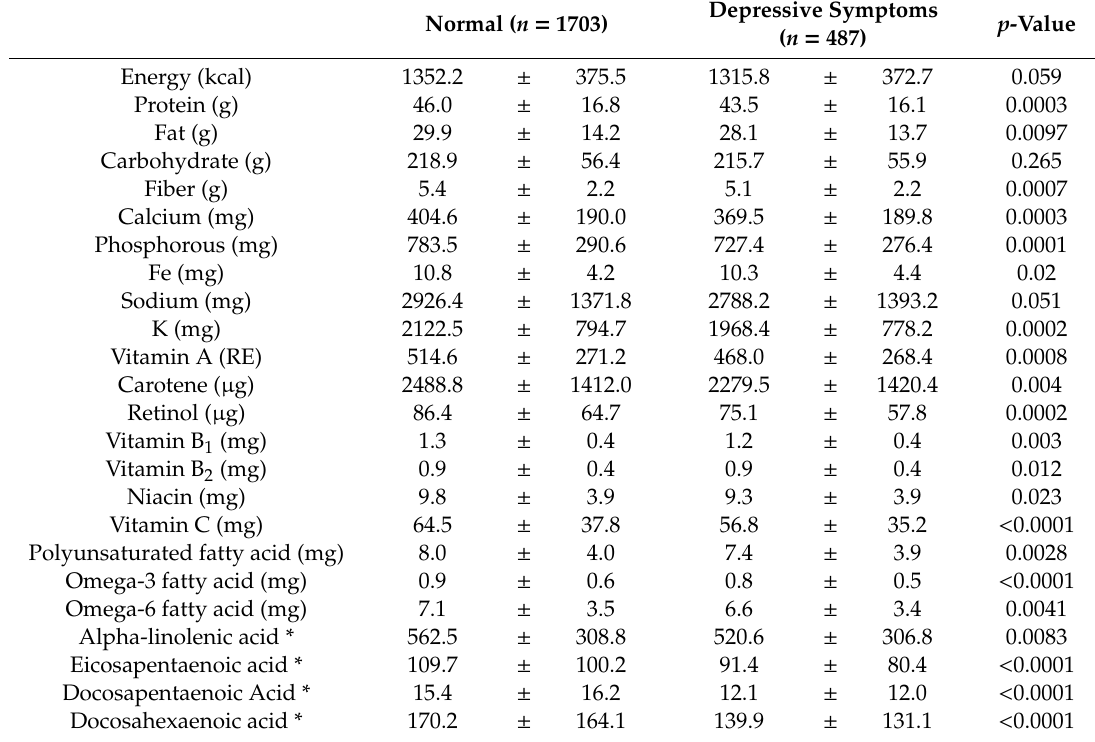
Table 2. Baseline nutrient and fatty acid intakes in study